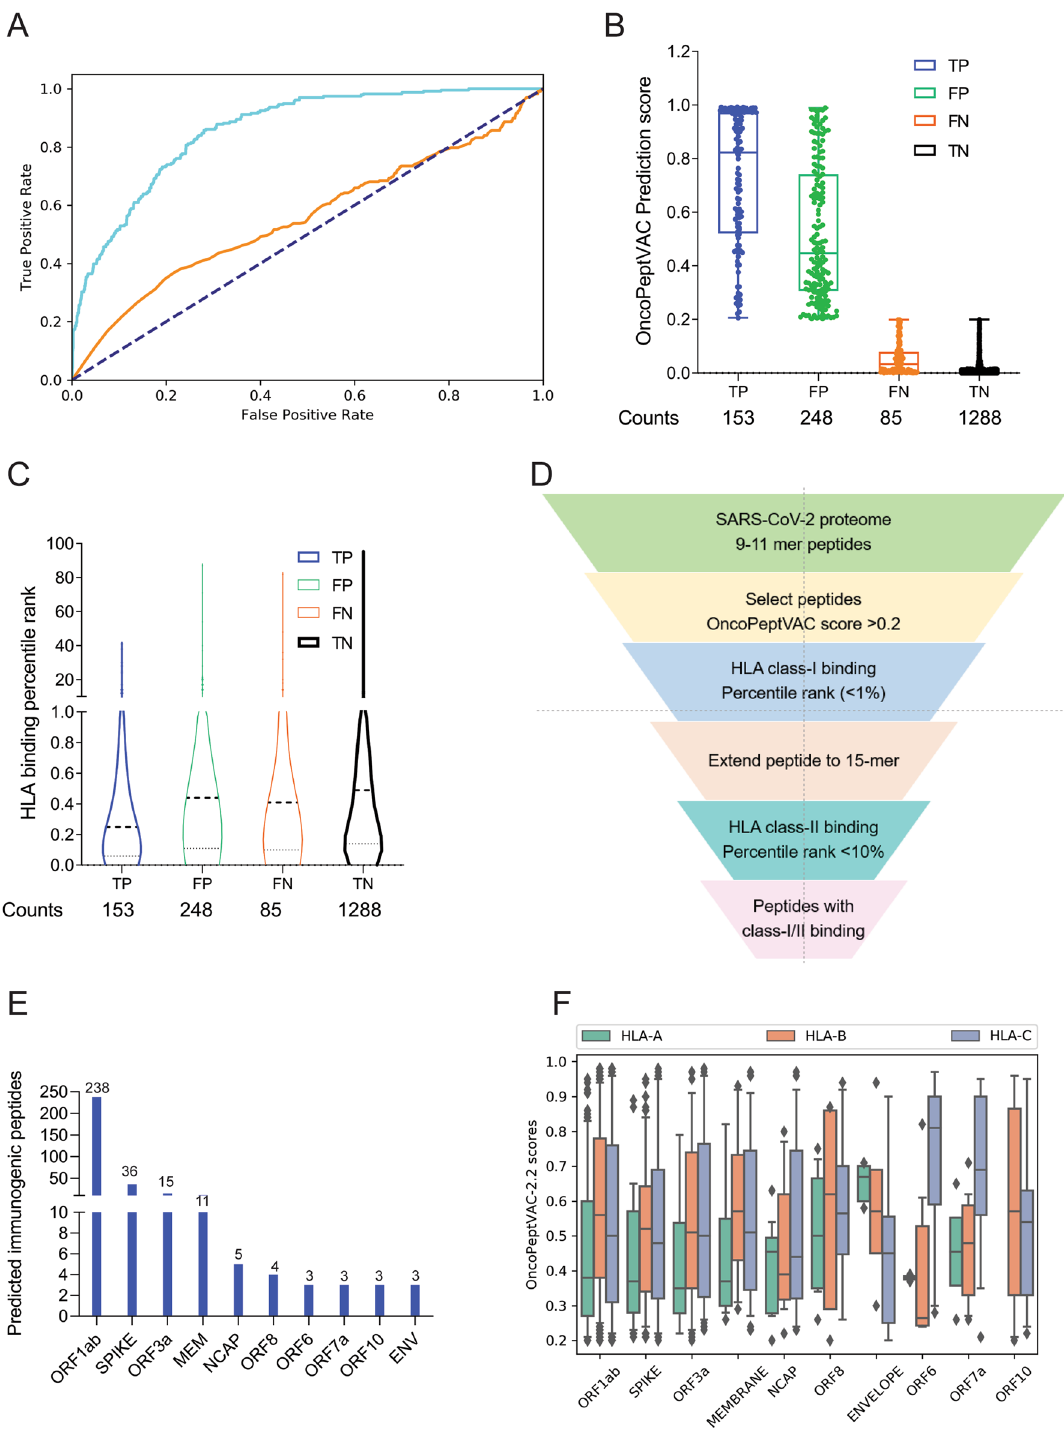
Figure 1. Identification of immunogenic epitopes from SARS-CoV-2 by OncoPeptVAC. ( A ) ROC curves of OncoPeptVAC TCR-binding and netMHCpan-4.1 HLA binding algorithms. A blind dataset of non- immunogenic or immunogenic HLA class-I binding T-cell epitopes from IEDB was used to assess the performance of OncoPeptVAC (cyan). The HLA-binding affinity of the epitopes expressed as percentile rank < 1% was used to assess the performance of netMHCpan-4.1 in predicting true immunogenic epitopes (orange). ( B ) Separation of immunogenic from non-immunogenic epitopes by OncoPeptVAC score. ( C ) Separation of immunogenic from non-immunogenic epitopes by HLA-binding percentile rank. ( D ) Schematic showing the steps used to identify immunogenic epitopes from SARS-CoV-2 proteome. ( E ) Number of immunogenic epitopes identified in different SARS-CoV-2 antigens. ( F ) HLA-A, B and C-restricted epitopes from SARS-CoV-2